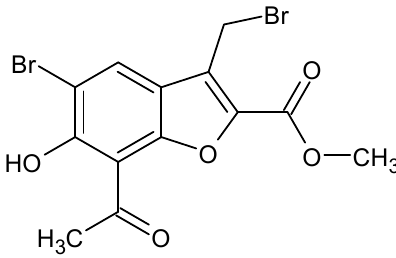
Figure 1. The structure of amioder .